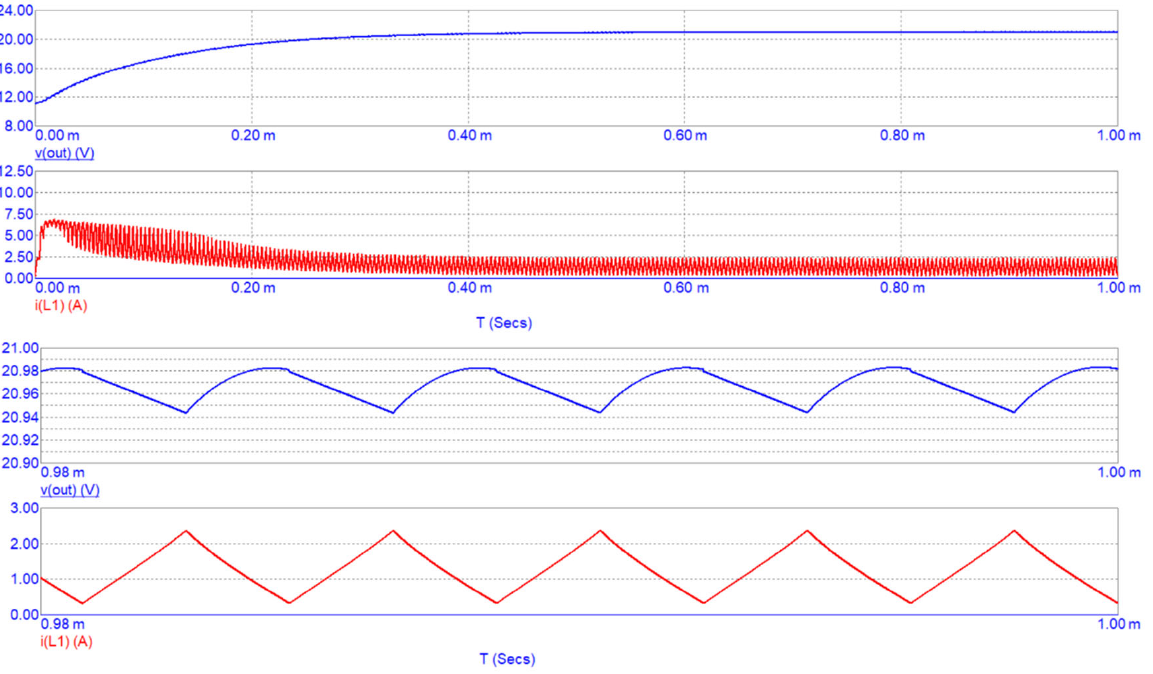
Figure 14. Simulation results of the DC/DC boost converter in Micro ‐ Cap Spice simulator with a non ‐ linear inductor implementing the polynomial model. Top figure depicts the output voltage of the converter and the inductor current. Bottom figure depicts a detail of the inductor current and output voltage profiles.